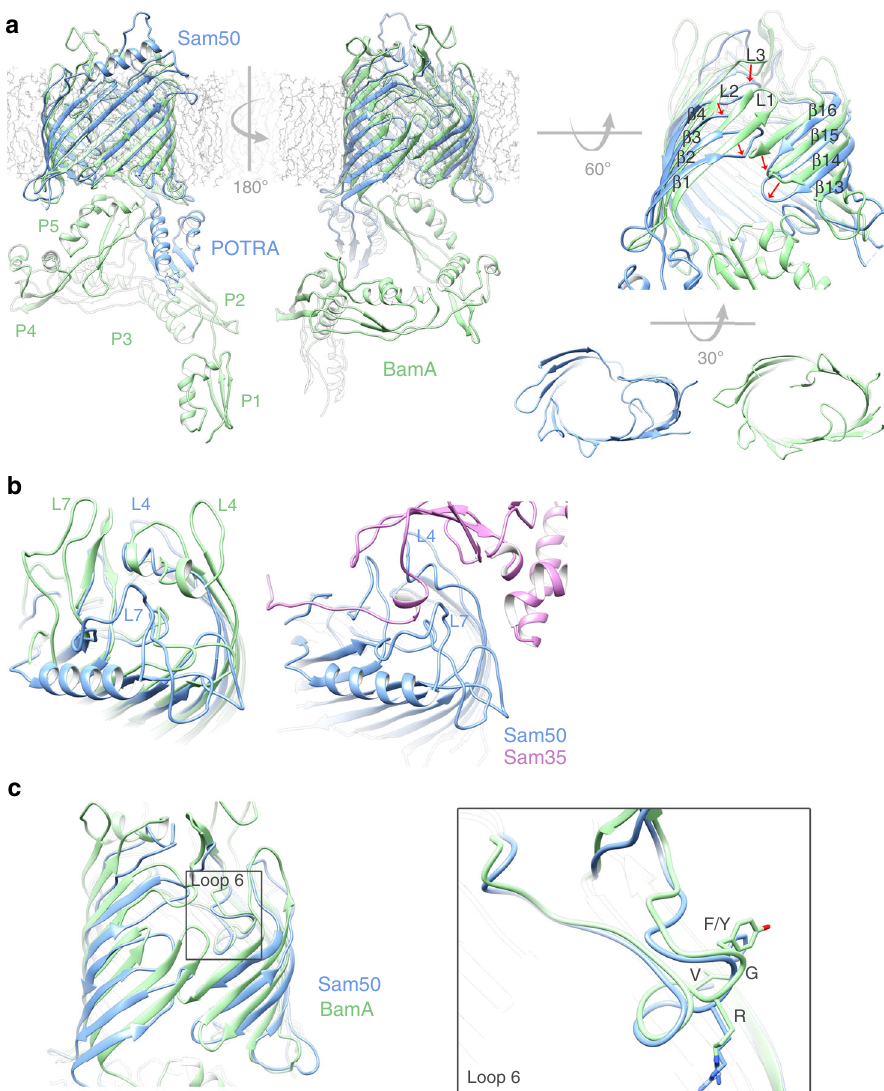
Fig. 6 Comparison of Sam50 to BamA. a Superposition of Sam50 (blue) and BamA (green PDB:4K3B) Right: close-up of the Sam50 lateral gate in detergent GDN compared to BamA and a bottom view of the barrel. The displacement of loops between the two structures is shown by red arrows. b Differences between Sam50 and BamA in outward facing loops L4 and L7 in the context of Sam35. c Superposition of loop 6 between the two structures. The conserved (V/I)RG(F/Y) motif is labeled. See also Supplementary Figs. 8, 9, 12, Supplementary Table 4, and Supplementary Movie